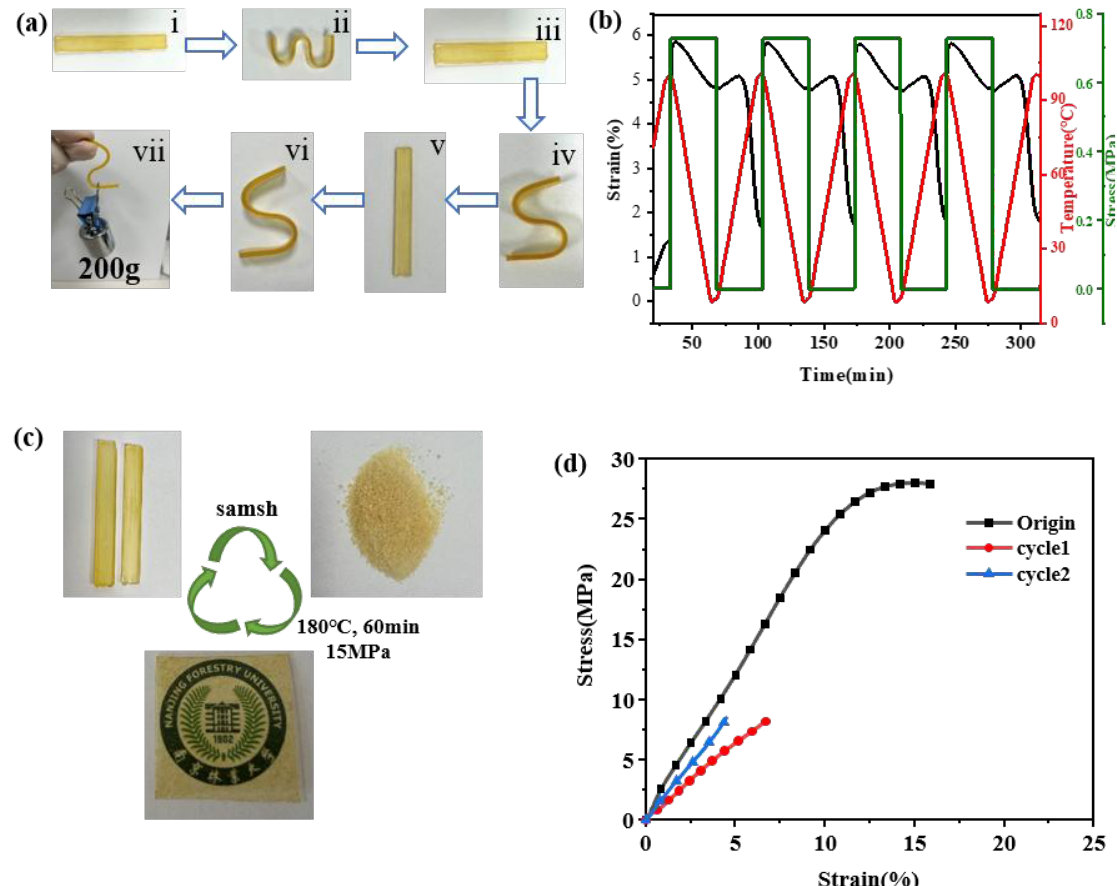
Figure 6. ( a ) Visual demonstration of shape-memory properties for TOMAH/H20%: ( i ) original rectangular shape, ( ii ) temporary W-shape, ( iii ) recover to the original rectangular shape, ( iv ) malleability-induced permanent S-shape, ( v ) temporary rectangular shape, ( vi ) recover to permanent S-shape, and ( vii ) the permanent S-shape can withstand 200 g of weight. ( b ) Consecutive dual-shape-memory cycles of sample TOMAH/H20%. ( c ) Recycling process of the TOMAH/H20% sample. ( d ) Mechanical properties of the UV-cured materials before and after